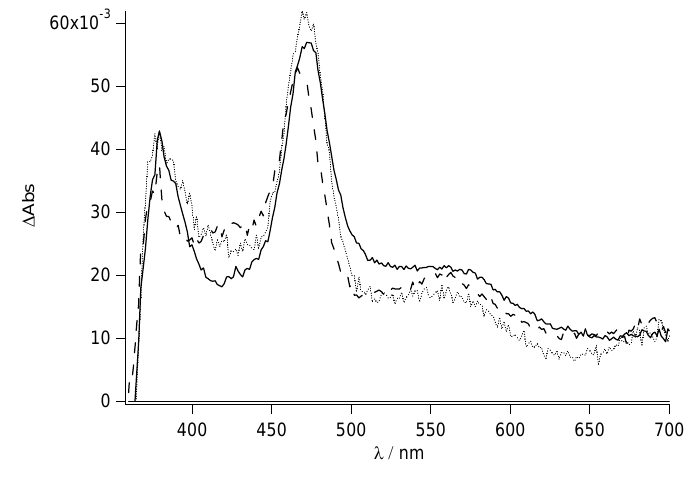
Figure 13. Sub-nanosecond transient absorption spectra of TpyPhPyrene Zn(TpyPhPyrene 200 ps incremental time